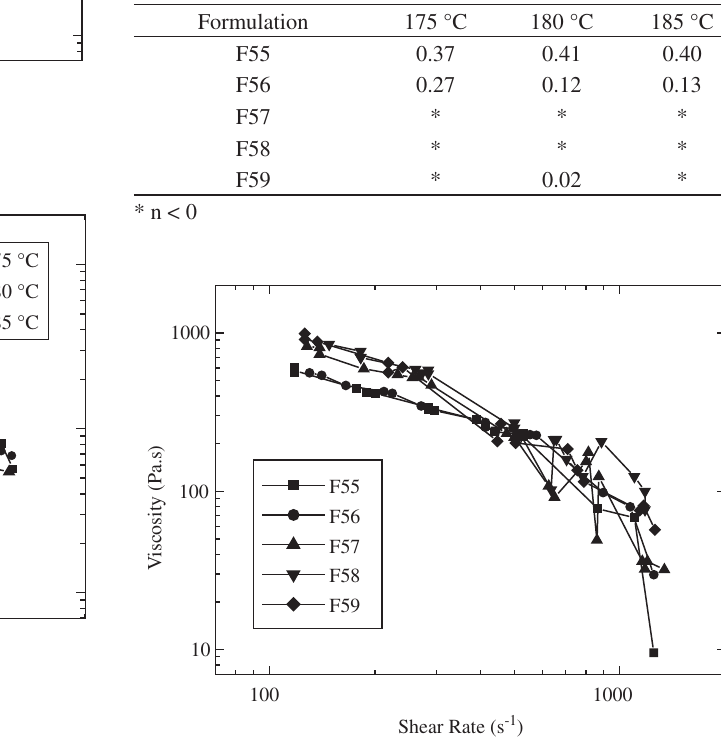
Figure 5. Viscosity vs. shear rate graphs of different formulation: a) F55; b) F57; c) F59. Figure 6. Feedstock viscosity vs. shear rate at 175